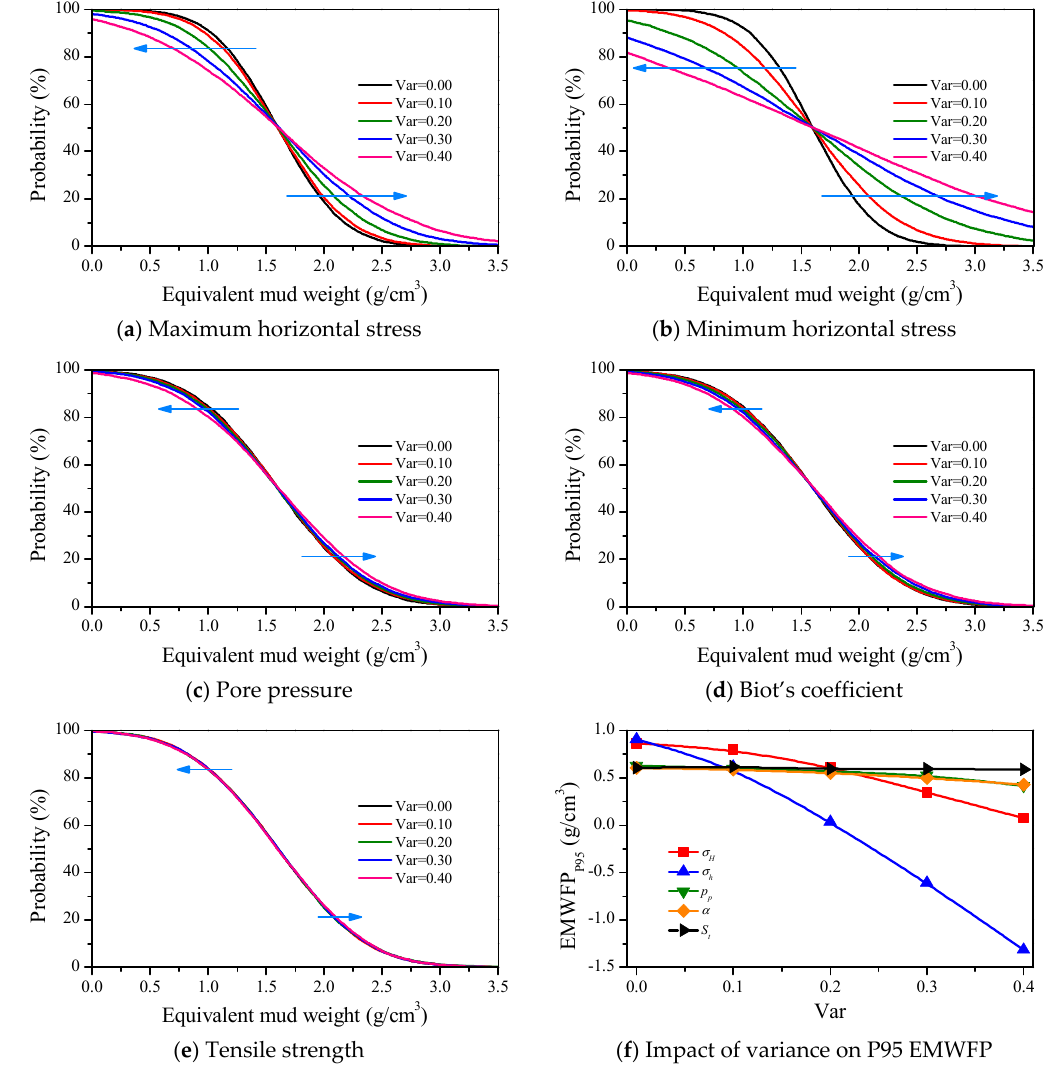
Figure 15. Influence of variance on cumulative probability of EMWFP.